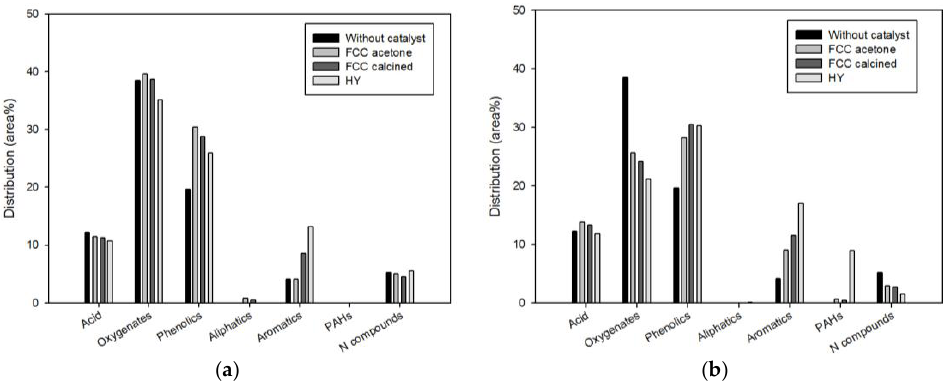
Figure 4. Pyrolysis product distribution obtained under different catalytic conditions at 500 °C: ( a ) biomass:catalyst = 1:1; and ( b ) biomass:catalyst = 1:10.